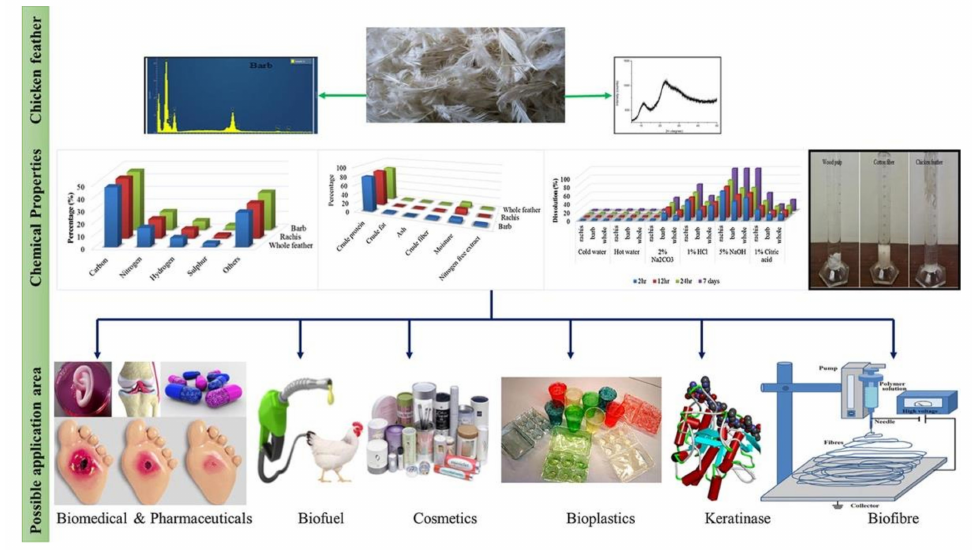
Figure 11. Possible valorization route of waste chicken feather based on chemical properties